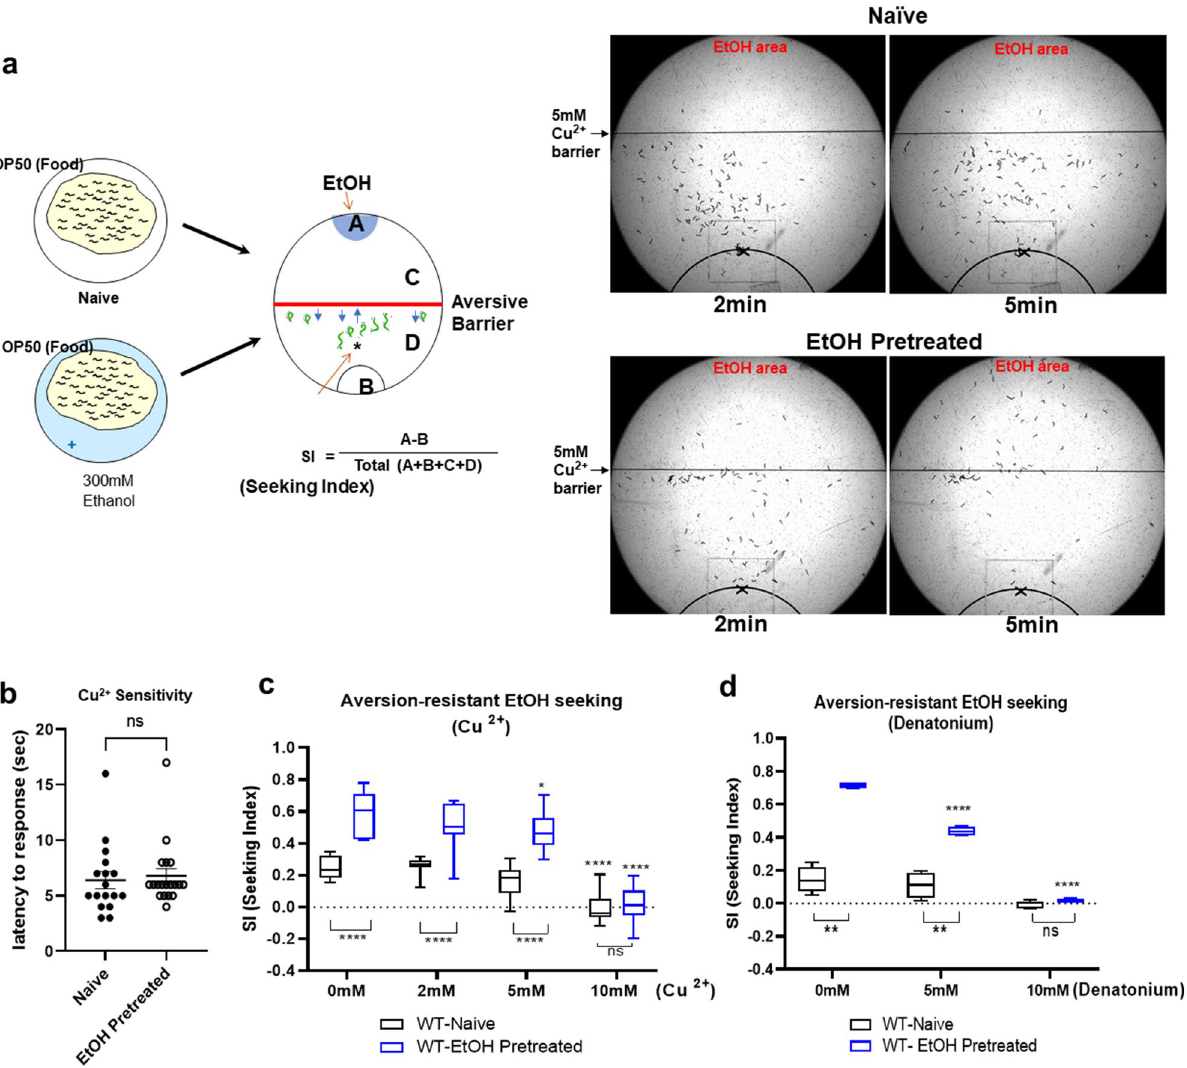
Figure 3. Behavioral quantification of compulsive ethanol seeking after exposure to ethanol against aversive chemical barrier. ( a ) Diagrammatic representation exhibited experimental design to quantify aversion-resistant ethanol seeking. The different concentrations of Cu 2+ created aversive barrier without mechanical obstacles to quantify the motivational strength of seeking ethanol behavior in animals. ( b ) Cu 2+ sensitivity of WT animals are not altered after ethanol exposure. ( c ) EtOH pretreated animals demonstrates more animals cross over the Cu barrier for ethanol (aversion-resistant seeking), in low concentration (2 and 5 mM), than does Naïve animals [F EtOH pretreated (1, 18) = 46.44, p < 0.0001; F Concentration (4,72) = 99.01, p < 0.0001; F pretreated×Concentration (4, 72) = 11.57, p < 0.001]. Moving to higher concentration of copper (10 mM), ethanol pretreated WT animals failed to overcome the aversive barrier. A two-way ANOVA comparison of the animal status over concentrations of barrier showed significant differences based on EtOH pretreated, concentrations, and the interaction of the two. Significant post hoc differences (Bonferroni’s test) between naïve and EtOH pretreated animals at no barrier, 2 mM, 5 mM, and 10 mM is shown. Comparison with 0 mM is also shown ( p < 0.0001,****). Values are mean ± SEM. N = 10 in each conc. ( d ) EtOH pretreated animals demonstrates more animals cross over the Denatonium barrier for ethanol (aversion-resistant seeking), in low concentration, than does Naïve animals [F EtOH pretreated (1, 6) = 598.8, p < 0.0001; F Concentration (1.712, 10.27) = 119, p < 0.0001; F pretreated×Concentration (2, 12) = 45.81, p < 0.0001]. A two-way ANOVA comparison of the animal status over concentrations of barrier showed significant differences based on EtOH pretreated, concentrations, and the interaction of the two. Significant post hoc differences (Bonferroni’s test) between naïve and EtOH pretreated animals at no barrier, 5 mM, and 10 mM is shown ( p < 0.01, **). Comparison between genotype is also shown ( p < 0.0001, ****). Values are mean ± SEM. N = 4 in each